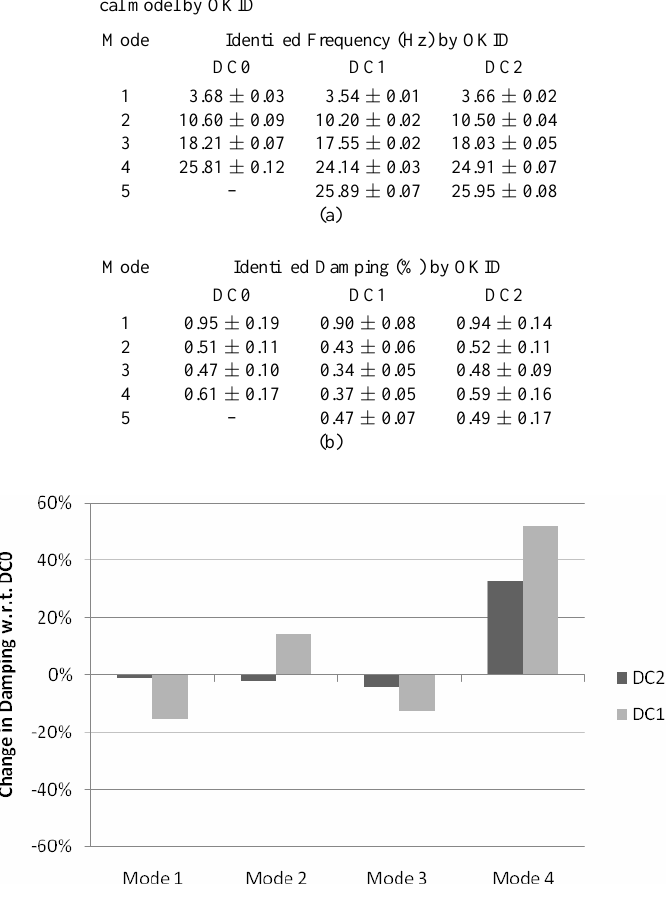
Table 6 Identified frequencies (a) and damping ratios (b) of physi-